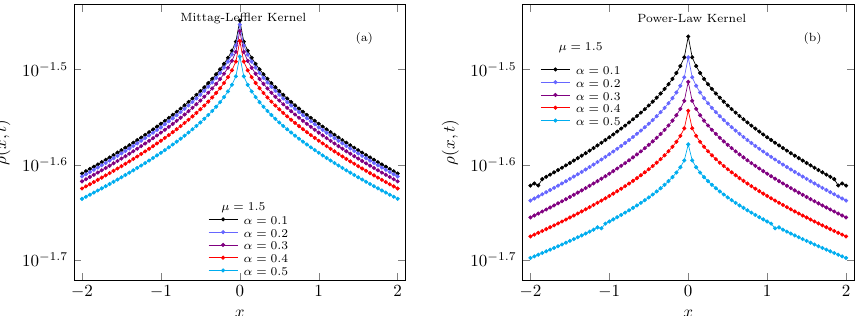
Figure 1. These figures show a series of distributions that represent the differences among Mittag–Leffler kernel ( a ) and power-law kernel ( b ) in Lévy process. The Mittag–Leffler Lévy flights are represented by Equation (32); and the fractional Caputo derivative in the Lévy process is represented by Equation (4). In both figures, we consider the follow values: µ = 1.5 (Lévy process), t = 10 0 , α -index. Moreover, in both figures, we use the same scale to make the differences clear.